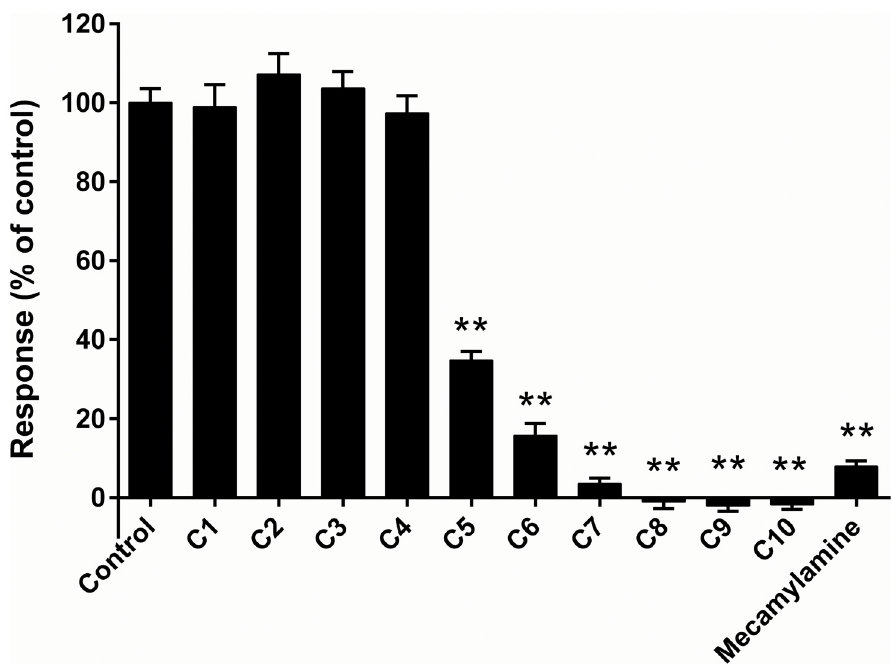
Fig 5. Inhibition of nicotinic responses in SH-SY5Y cells. Ca 2+ -responses were induced by nicotine (50 μ M) and the test compounds were all applied at a concentration of 100 μ M. Data are displayed as the mean ± SEM of two experiments with eight replicates on each plate. ** significant difference from control (p < 0.01, ANOVA with Dunnet ’ s post hoc test).